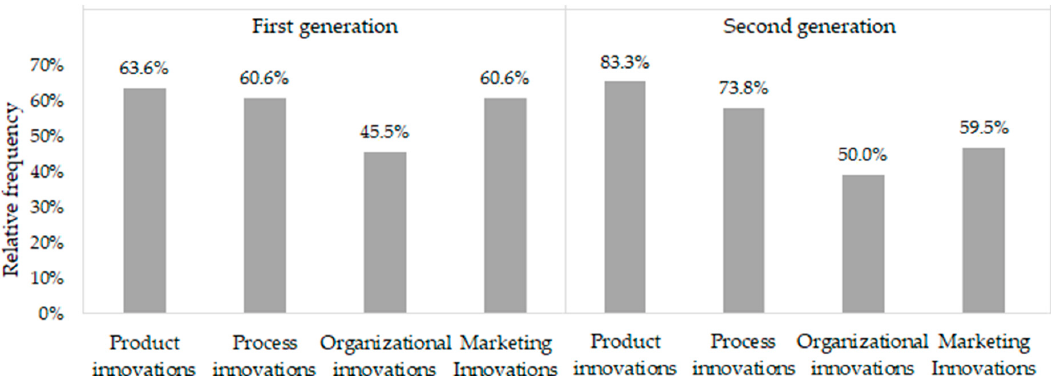
Figure 3. The relative frequencies of the number of types of introduced innovations grouped by the generation running the company.